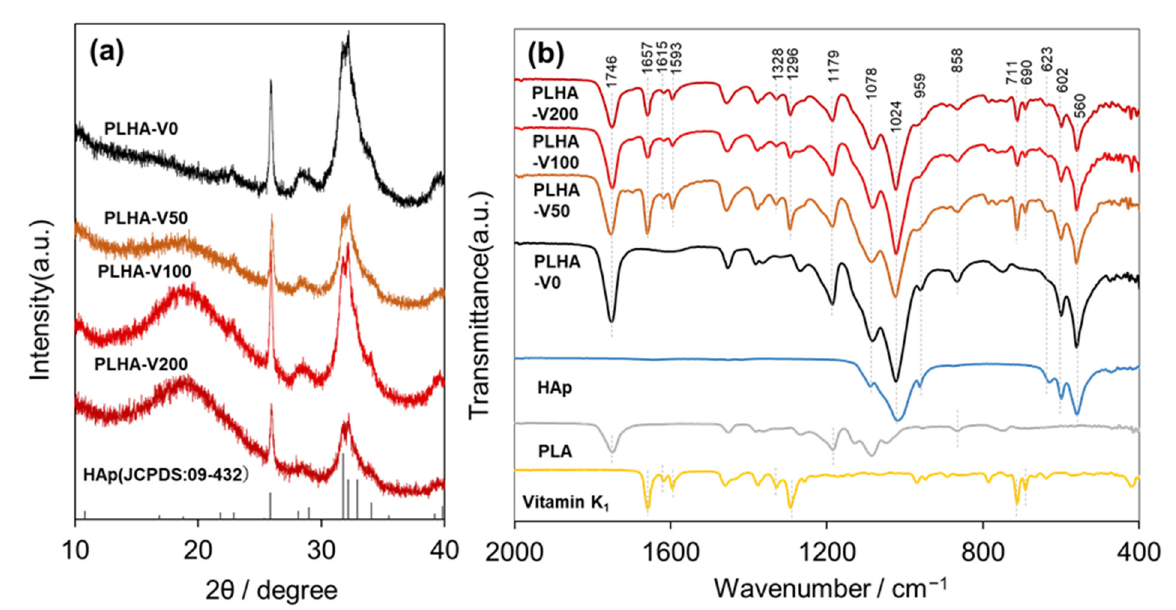
Figure 1. ( a ) X-ray diffraction (XRD) patterns and ( b ) Fourier transform infrared (FT-IR) spectra for the PLHA-V x particles.